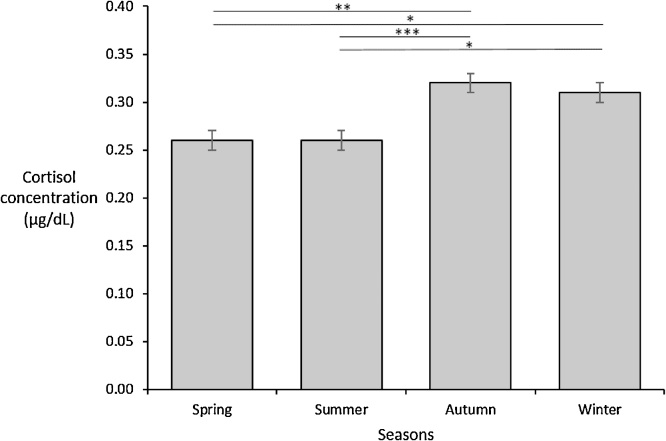
Mean salivary cortisol concentration by season, with error bars representing standard error. * < 0.05 ** < .005 ***< .001.